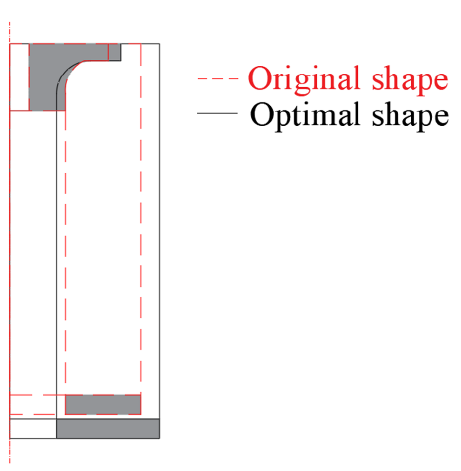
Figure 15. Comparison of cross-section shape for cylindrical polyurethane spring.